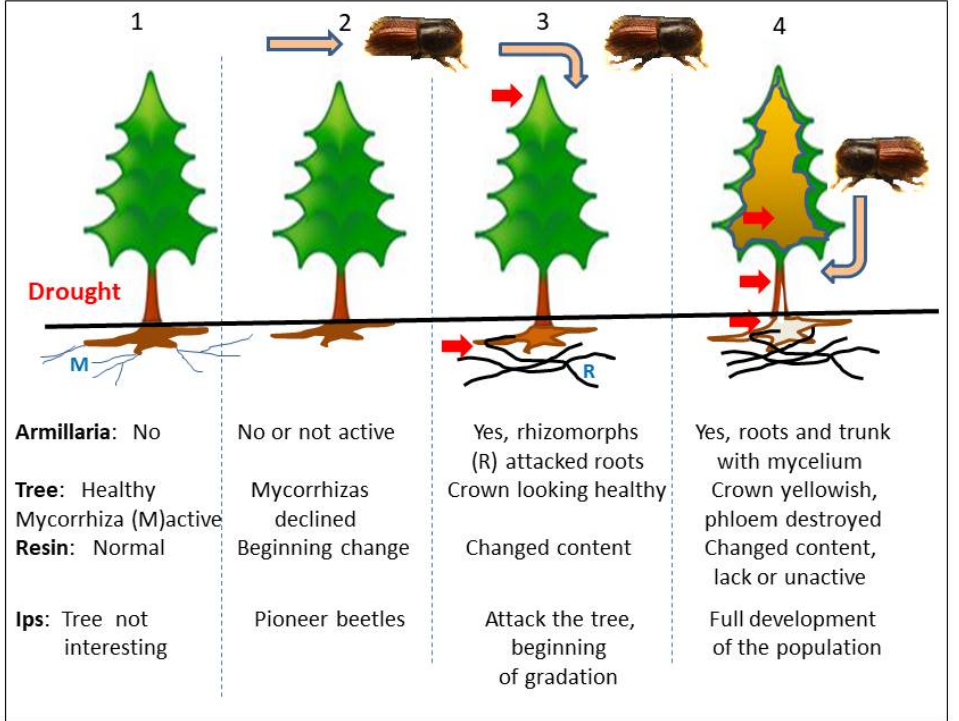
Figure 1. The phases (1–4) of colonization of stressed Norway spruce trees by Armillaria and Ips